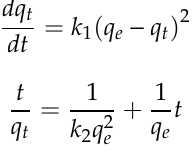
Figure 7. ( a ) Pseudo-first-order and ( b ) pseudo-second-order kinetic plots of commercial gamma alumina and the synthesized BSMA adsorbents on ammonia adsorption.